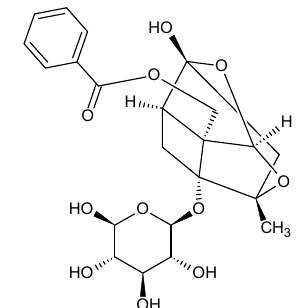
Figure 2. Chemical structure of paeoniflorin. Acetophenones are also characteristic compounds of P. × suffruticosa , such as: 2,3- dihydroxy-4-methoxyacetophenone, gallacetophenone, p -hydroxyacetophenone, 3- hydroxy-4-methoxyacetophenone and reacetophenone (Figure 3). Noteworthy